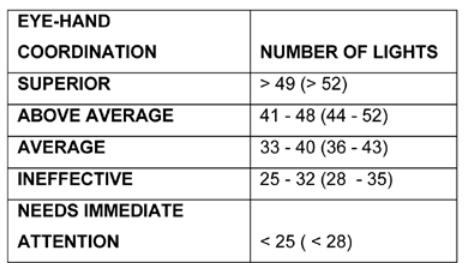
Table 4: The norms for eye-hand coordination with the use the Computerized Wayne Saccadic Fixator. The results in brackets are from Buys 4